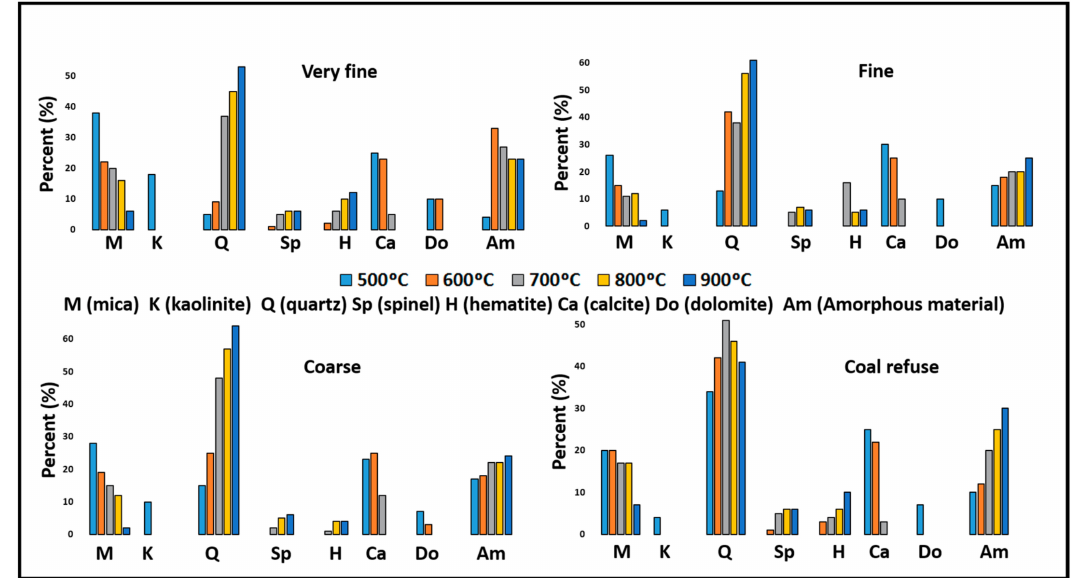
Figure 7. Mineralogical composition by XRD from the thermally activated samples between 500 ◦ C and 900 ◦ C.